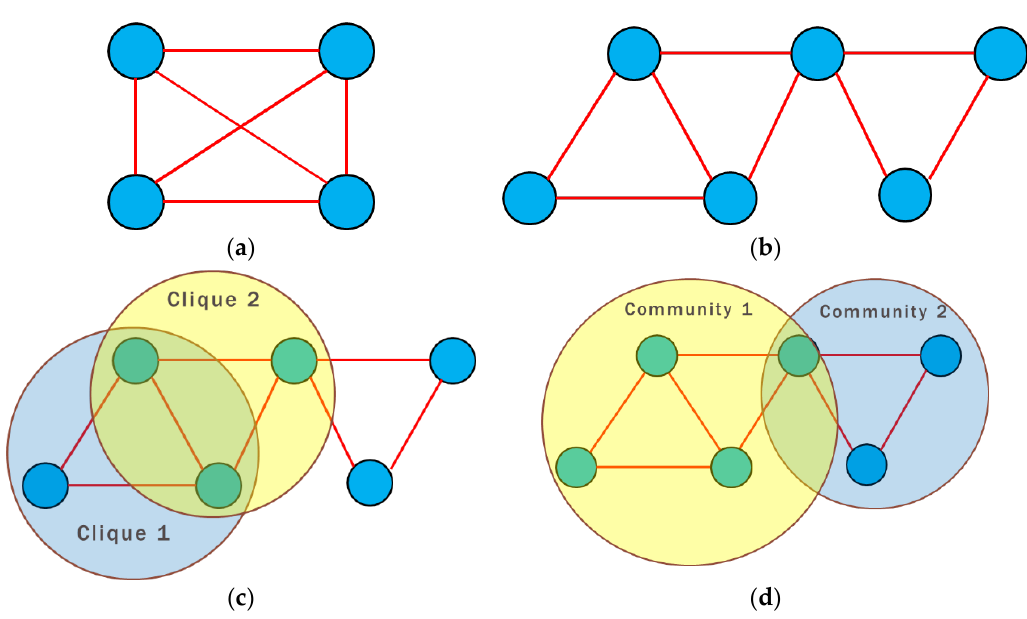
Figure 4. Detection algorithm for k-communities. ( a ) Cliques detection with size k ( b ) Detection of the sequence of Cliques ( c ) Selection of the Clique ’ s neighbors with size k-1 ( d ) Formation of K – Communities. Source: authors’ own calculations.